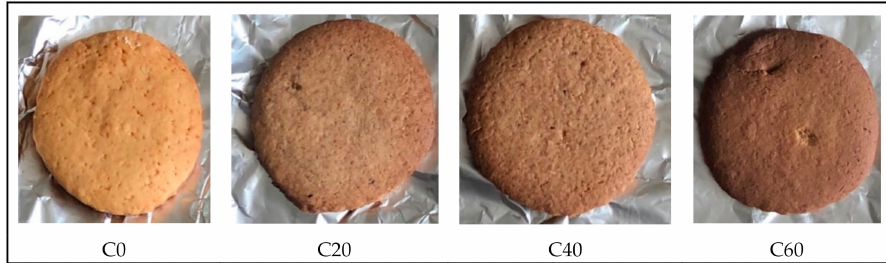
Figure 1. Cookies fortified with sorghum and termite. C0: control (100% wheat cookies); C20: 15% sorghum and 5% termite substitution level; C40: 30% sorghum and 10% termite substitution level; C60: 45% sorghum and 15% termite substitution